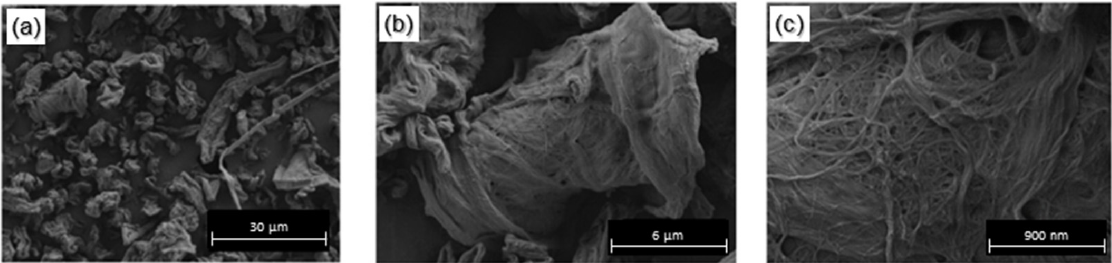
Figure 3. Field emission scanning electron microscopy (FESEM) micrographs of the atomized microfibrillated cellulose (MFC) observed at different magnifications, as follows: ( a ) taken at 1000 × with a scale marker of 30 µ m; ( b ) 5000 × and 6 µ m; ( c ) 20,000 × and 900 nm.